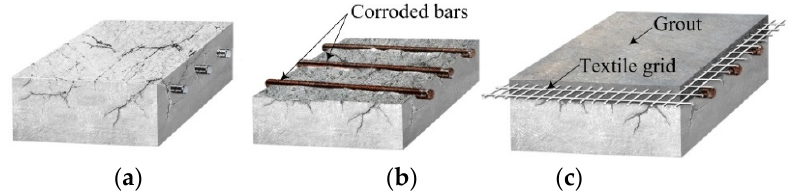
Figure 2. ( a ) deteriorated concrete element; ( b ) removing deteriorated concrete cover; and ( c ) installation of TRC system with grout.